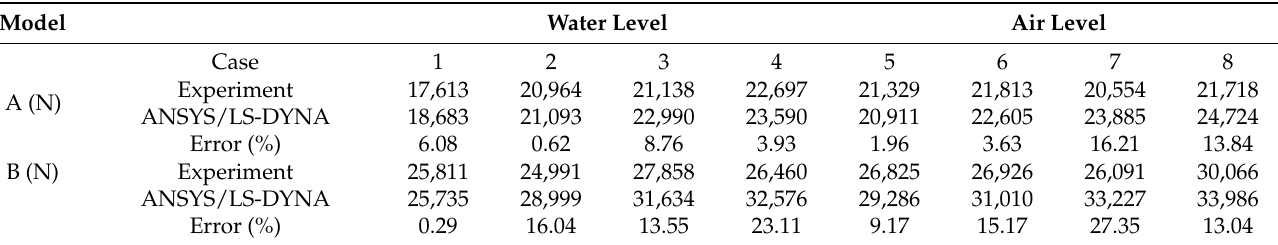
Table 9. Summary of experimental and numerical analysis